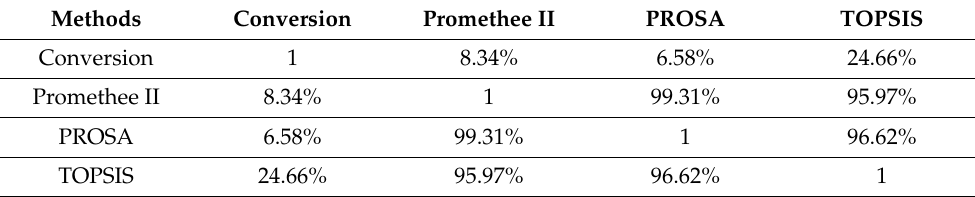
Table 9. Correlation matrix between the results obtained with the conversion, TOPSIS, Promethee II and PROSA methods (R 2